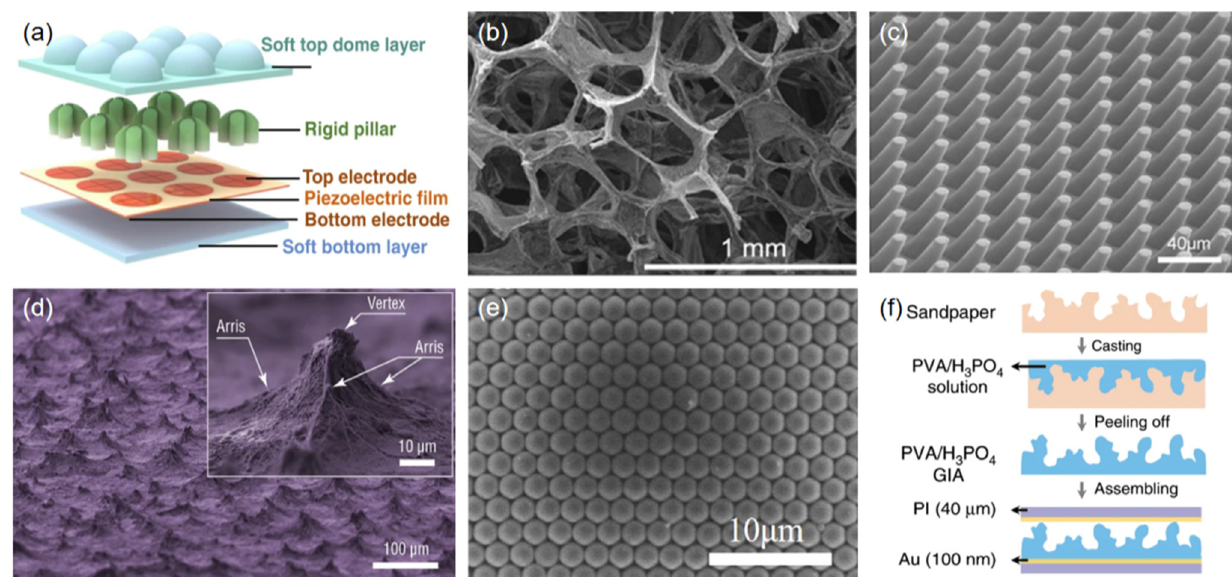
Figure 5. ( a ) Schematic diagram of a finger-shaped sensor (reproduced with permission from [111]); scanning electron microscope (SEM) images of ( b ) porous RGO foam (reproduced with permission from [115]); ( c ) micropillars (reproduced with permission from [116]); ( d ) micropyramids (repro- duced with permission from [88]); ( e ) microconvex arrays (reproduced with permission from [89]); ( f ) schematic diagram of the architecture of GIA (reproduced with permission from [90]).